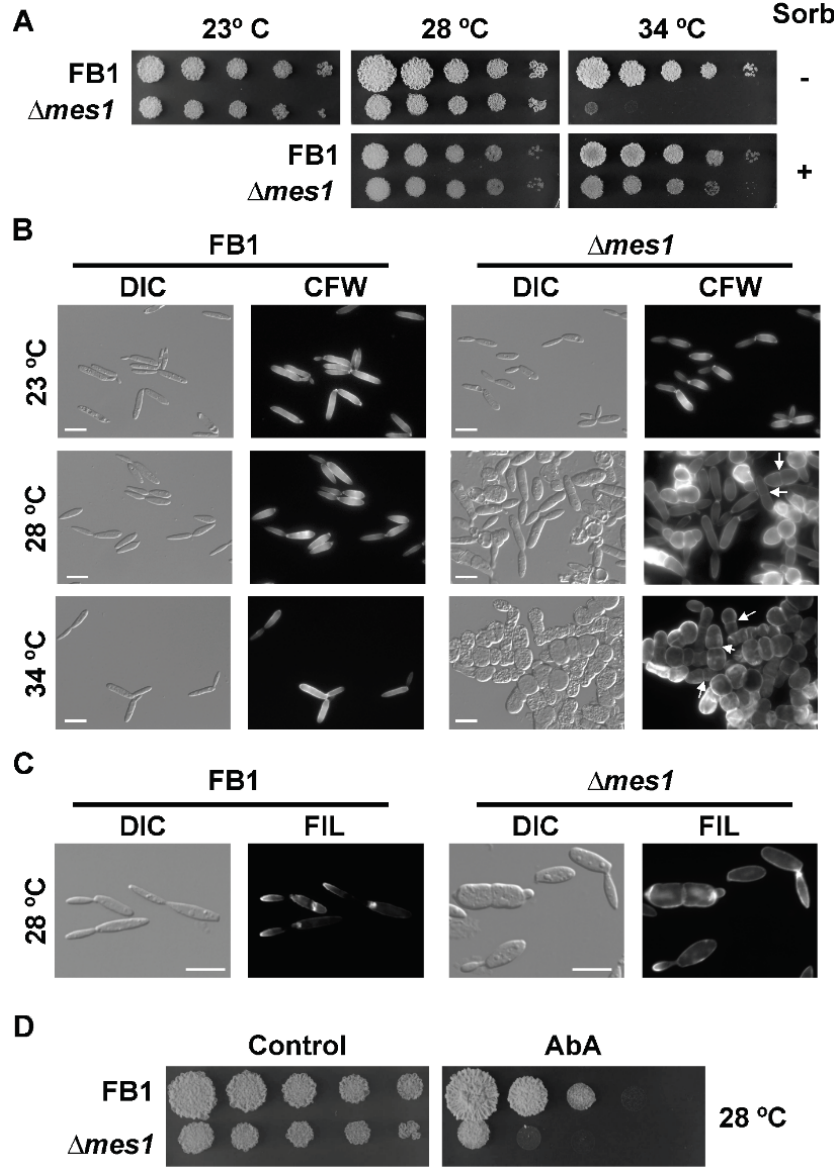
Figure 2. ∆ mes1 loss of polarity is temperature ‐ dependent. ( A ) Ten ‐ fold serial dilutions were spot